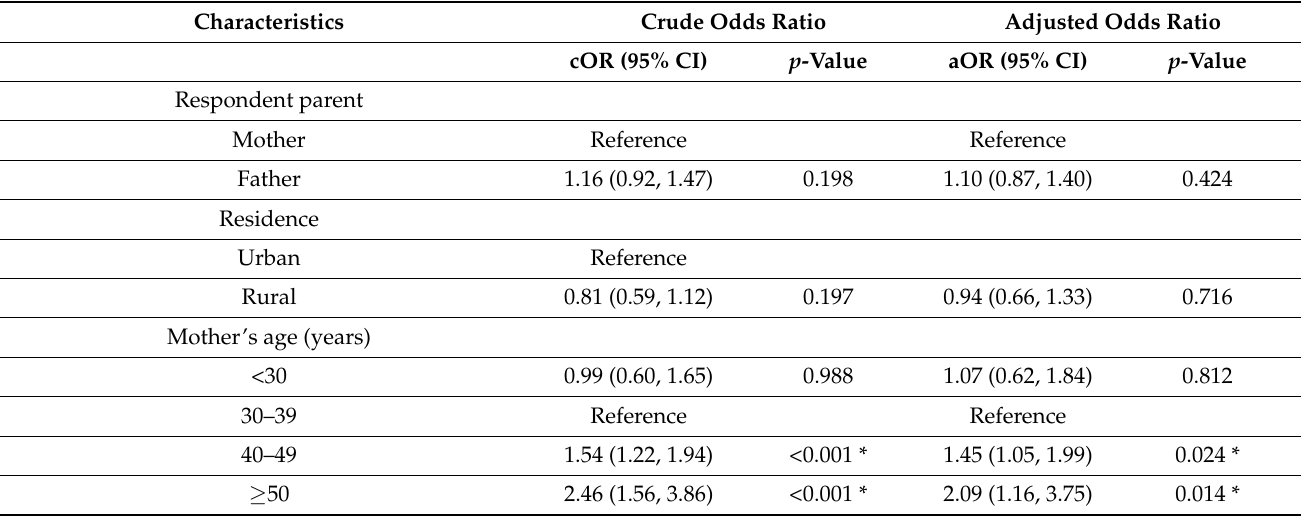
Table 3. Crude and adjusted odds ratio of factors associated with the intention of parents to vaccinate their